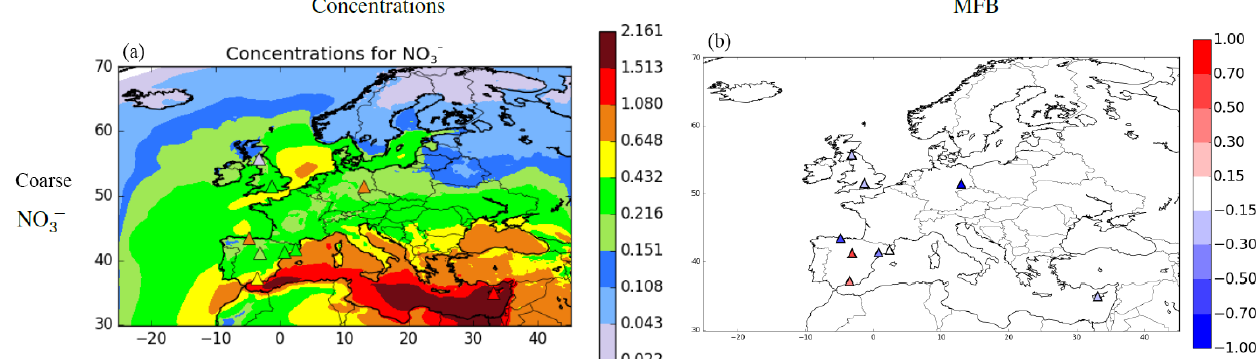
in 2013. Triangles correspond to measured concentrations in 3